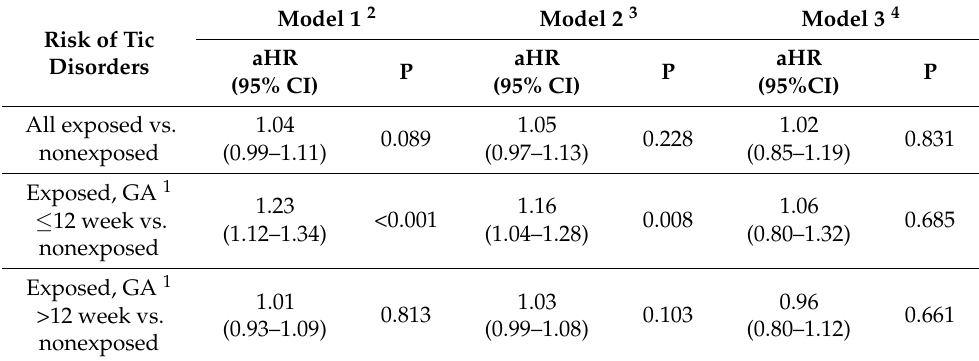
Table 2. Hazard ratios for TS and tics in offspring of mothers diagnosed with anemia during pregnancy, with consideration of the timing of